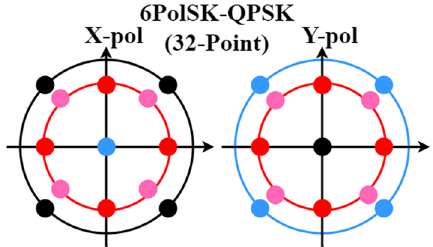
Fig. 2 32-Point 6PolSK-QPSK with different reference modulus in X and Y